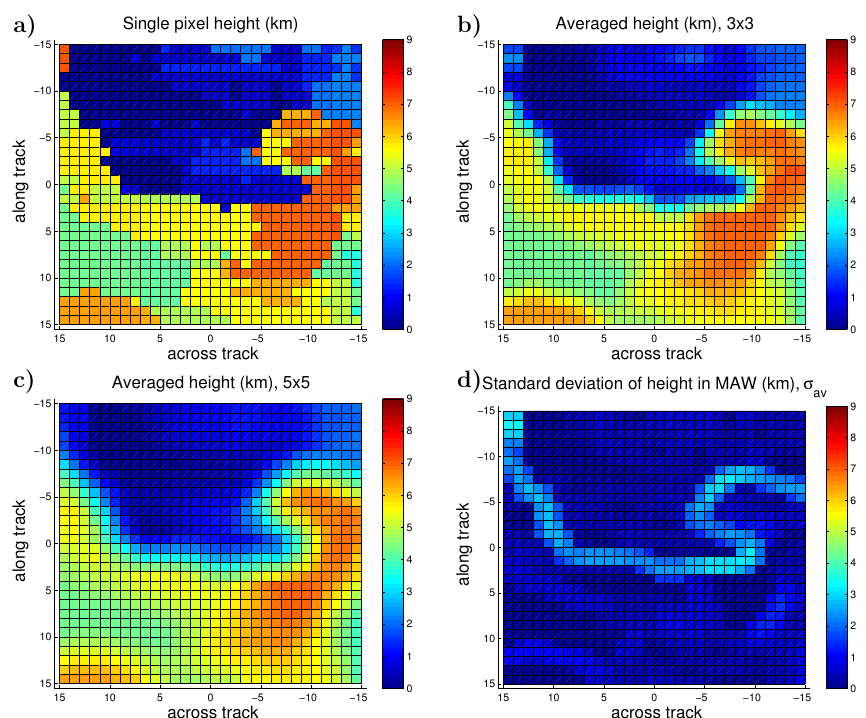
Figure 7. The effect of the averaging with a moving averaging window (MAW). (a) The initial single-pixel heights; (b) the MAW size 3 × 3 averaged values; (c) the MAW size 5 × 5 values. The averaging smooths the data, removing isolated peaks, but some details are lost. (d) The standard deviation of height within the MAW clearly indicates the plume